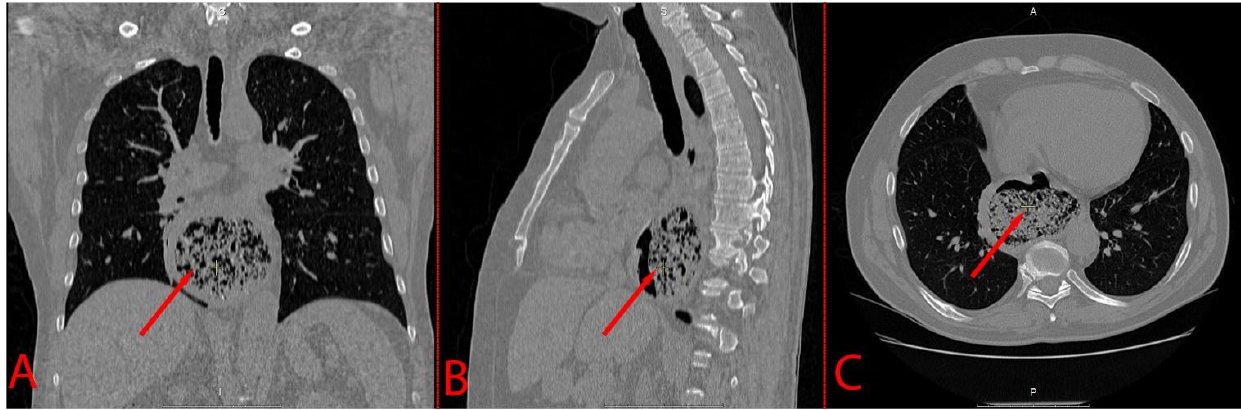
Figure 1 : Giant epiphrenic diverticulum. A: Coronal plane; B: Sagittal plane; C: Axial plane (arrow points at the diverticular